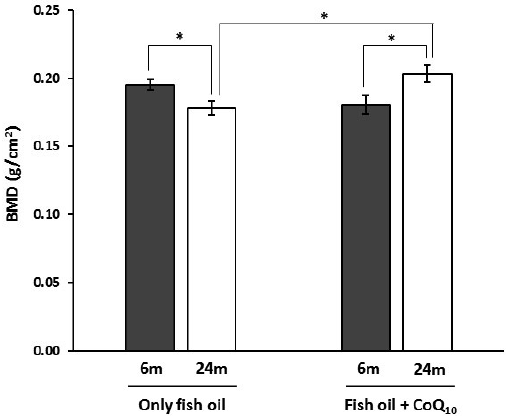
Figure 2. Effects of supplementation with coenzyme Q 10 (CoQ 10 ) on bone mineral density (BMD) in 6- and 24-month-old (m) rats fed fish oil as dietary fat. Results are expressed as mean ± standard error of mean of six animals. * Statistically significant differences ( p < 0.05) determined by the Student’s t -test.